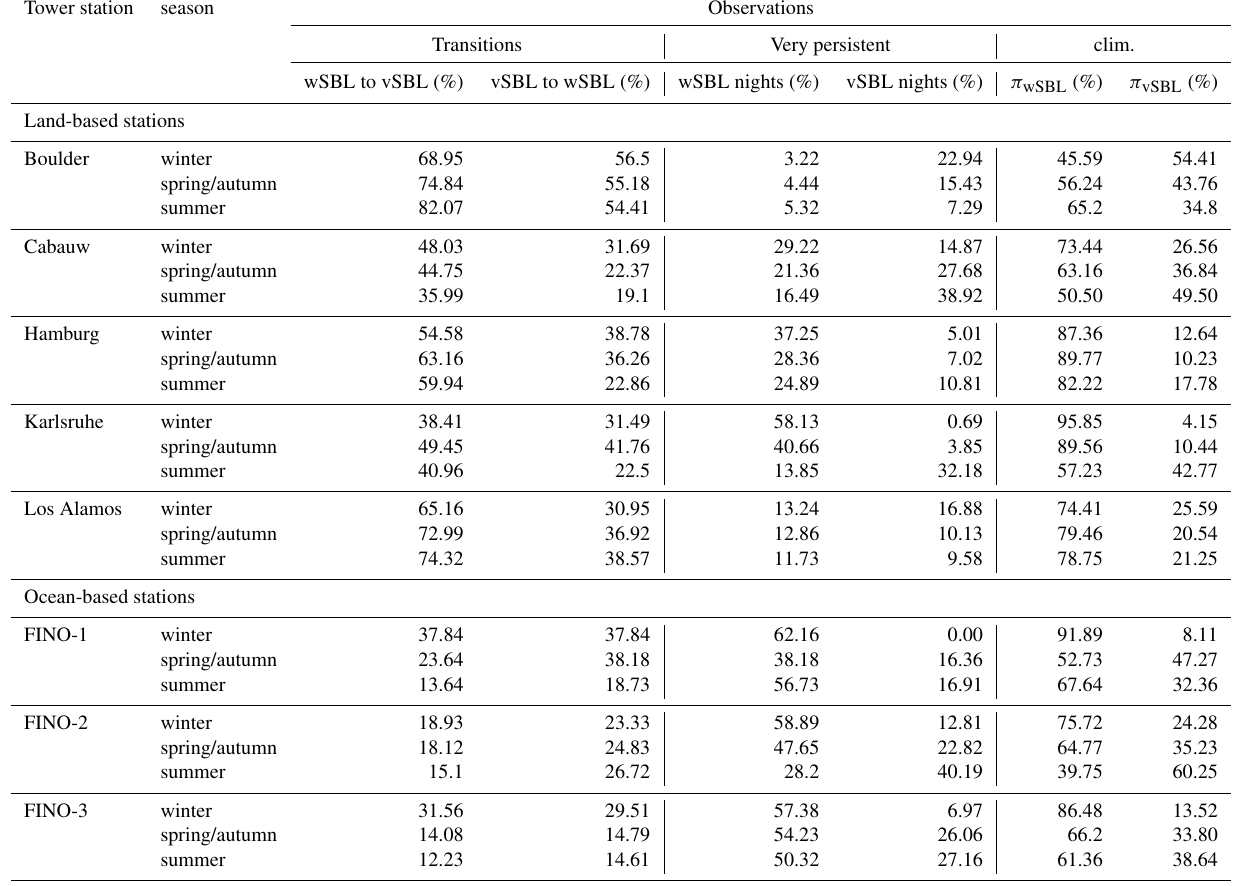
Table 3. Probabilities of the occurrence probabilities of at least one wSBL to vSBL or vSBL to wSBL transition in a night, of the occurrence probabilities of very persistent wSBL or vSBL nights, and of the climatological initial distributions of starting a night in the wSBL or vSBL (or π wSBL and π vSBL ) at the different tower sites for different seasons as estimated from the VP ref . Tower